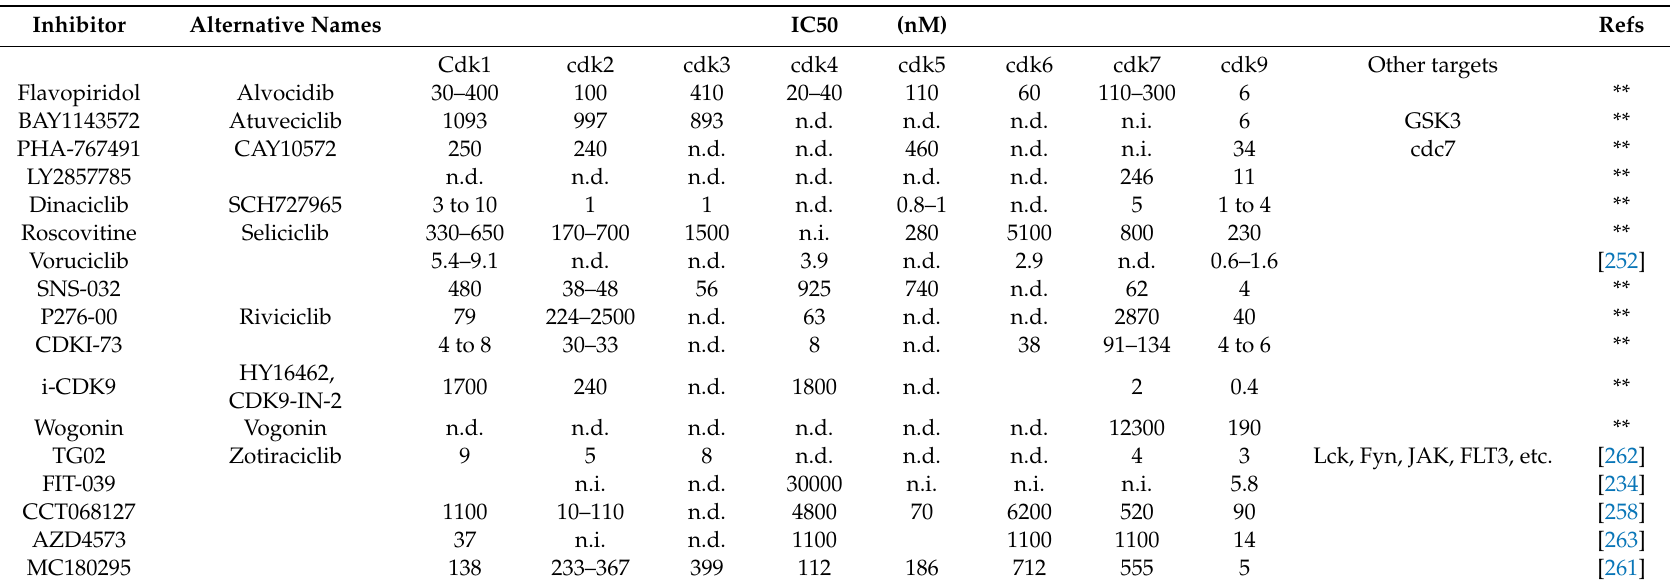
Table 2. Examples of Cdk9